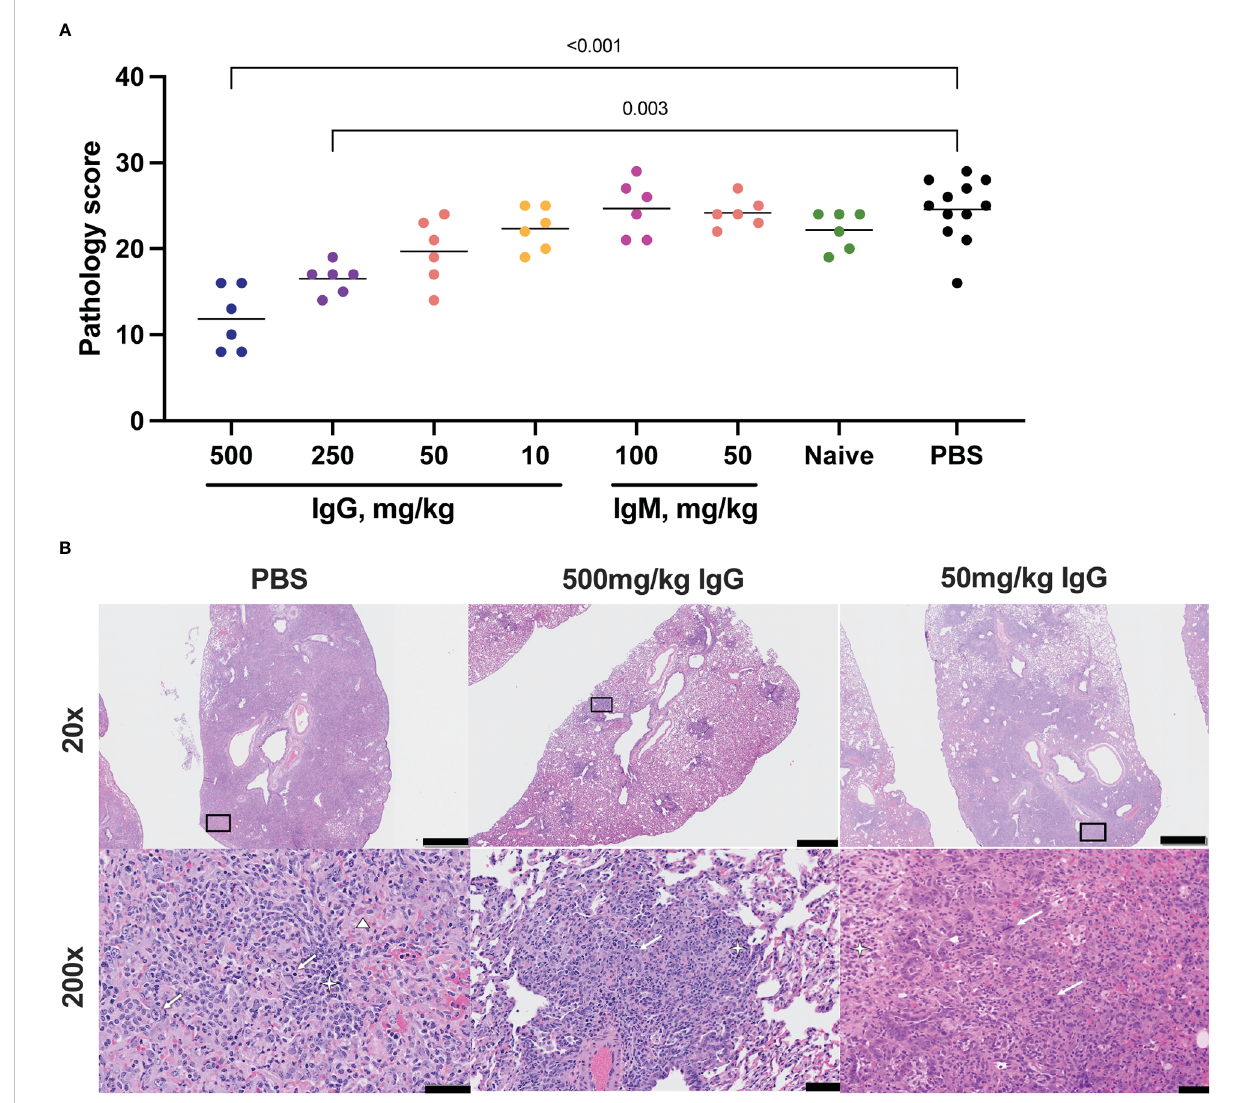
FIGURE 3 Histopathologic examination post-challenge. Lung tissues were collected at necropsy on day 7 post-challenge, fi xed with neutral buffered formalin, and stained with hematoxylin and eosin (H&E) for standard microscopic examination. (A) H&E stained slides were scored for pathologic effects (see Methods) in SARS-CoV-2 challenged hamsters. Dots represent individual animals and the horizontal bar is the mean group score. Each group was compared to the control group that received no antibody infusion by Kruskal-Wallis test with Dunn ’ s posttest and bars indicate signi fi cant differences (P<0.05). (B) Representative lung tissue sections from the 7 day PBS control, 7 day 500 mg/kg convalescent IgG, and 7 day 50 mg/kg convalescent IgG, challenged hamsters in the columns as indicated. Rows are given by H&E at 20 and 200 times magni fi cation power (20X and 200X, respectively). The black boxes in the top row indicate the area magni fi ed in the bottom row. Interstitial pneumonia is characterized by in fl ammatory cellular in fi ltrates (star), type II pneumocyte hyperplasia (thick arrow), bronchiolar epithelial hyperplasia, and hemorrhage and edema (triangle). Scale bars: Top row, 1 mm; bottom row, 50